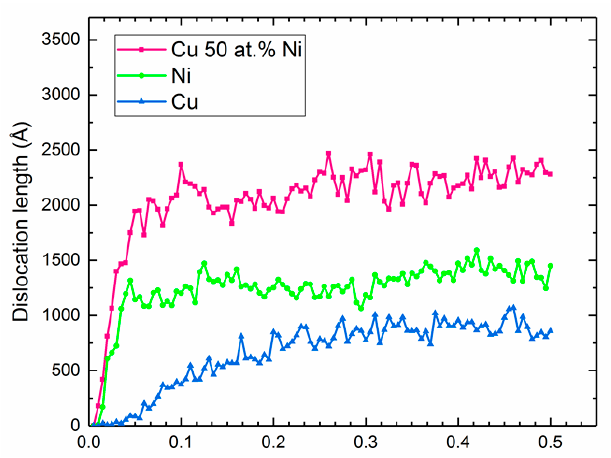
Figure 6. Stair-rod dislocation length as a function of strain.